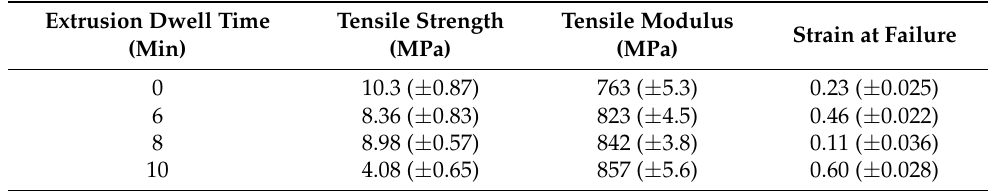
Table 4. Tensile strength, tensile modulus, and strain at failure of LLDPE/MP fibres for different extrusion dwell times. (Figures in brackets represent the standard deviation).